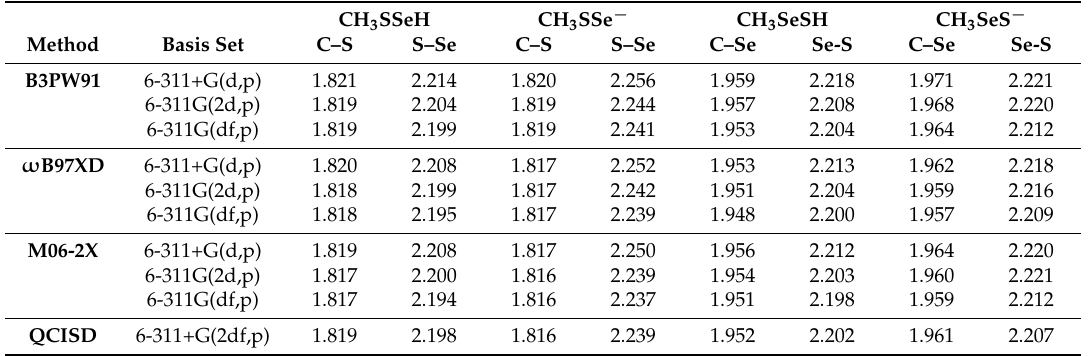
Table 3. Selected optimized bond lengths (in ångstroms; Å) for CH 3 XYH and CH 3 XY − (X = S, Se; Y = Se,